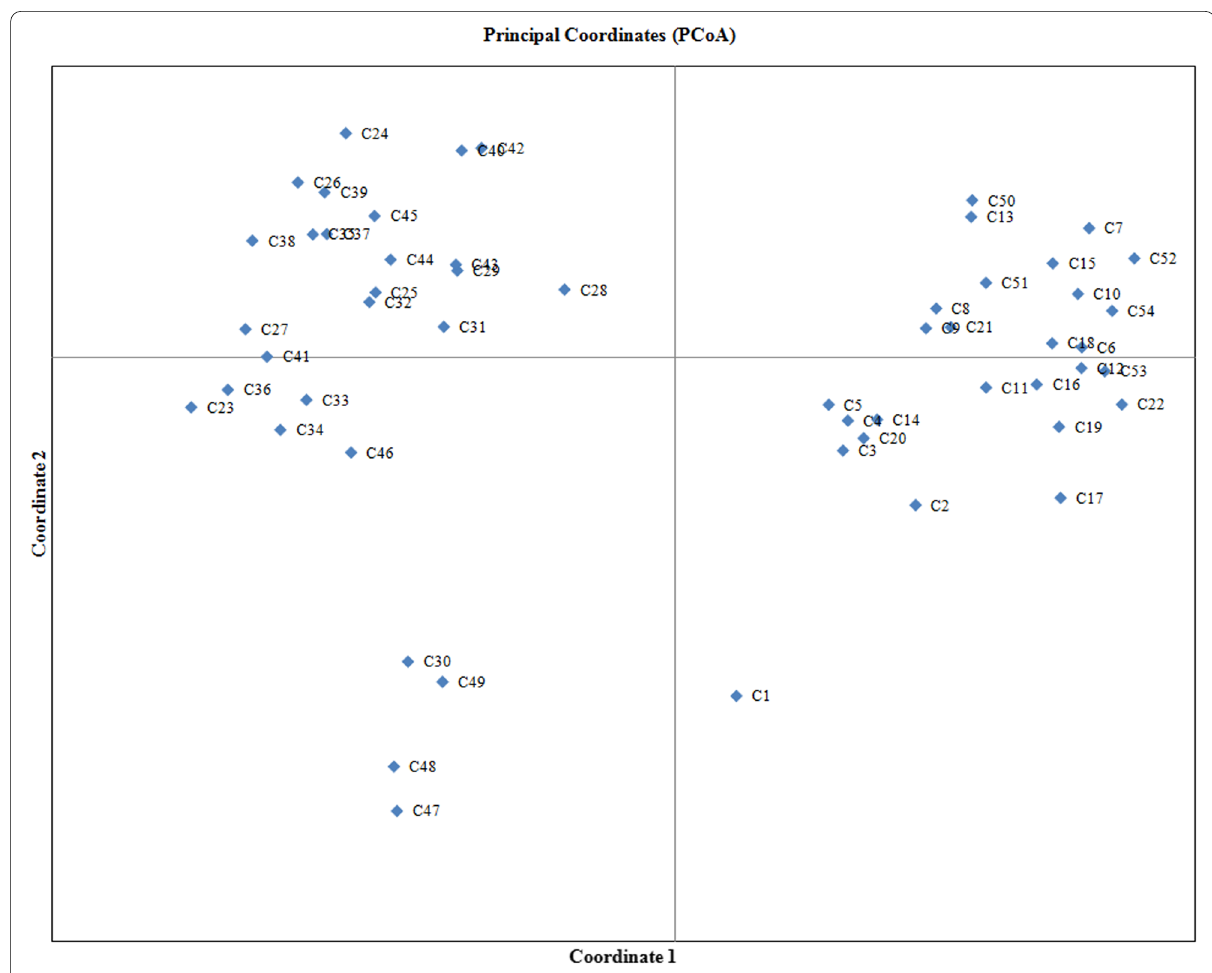
Fig. 8 Principal coordinate analysis (PCoA) of 54 Capsicum accessions. Horizontal and vertical scales correspond to the first and second principal axes of variation, respectively, which represents the degree of variations among various chilli accessions